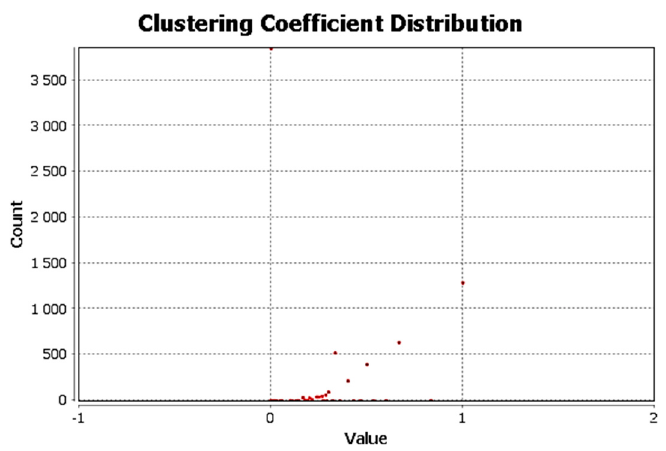
Figure 9. The clustering coefficient distribution of network ‘B’.